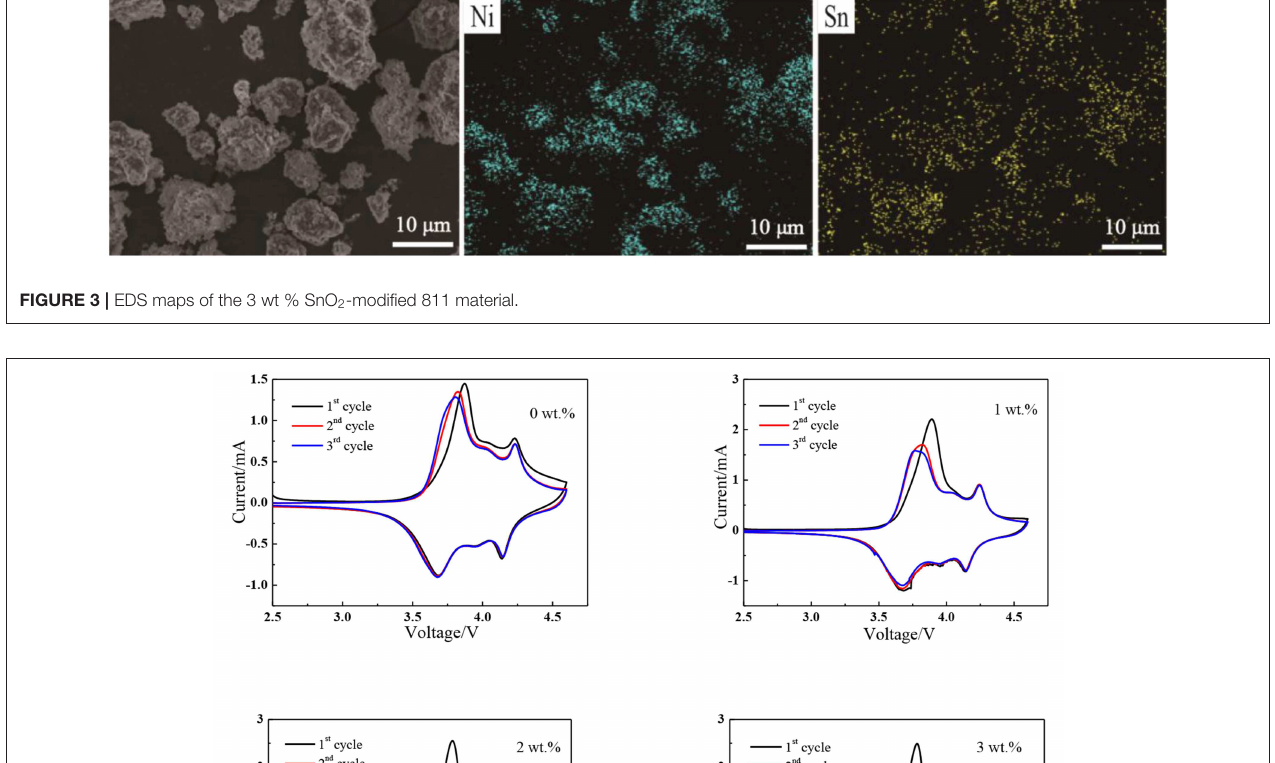
Frontiers in Energy Research |